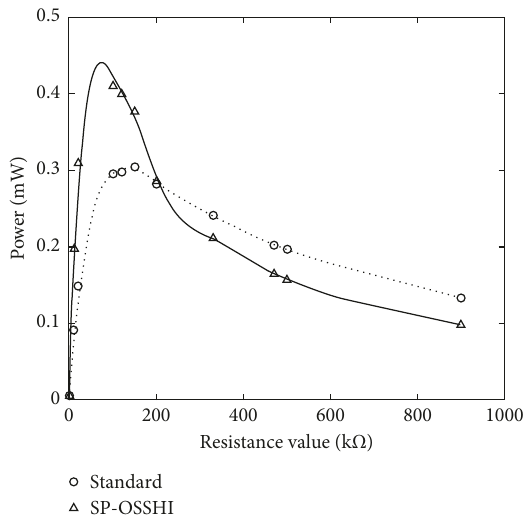
Figure 12: Two PEH circuits’ experiment output power with different load resistance values. Table 1: Component